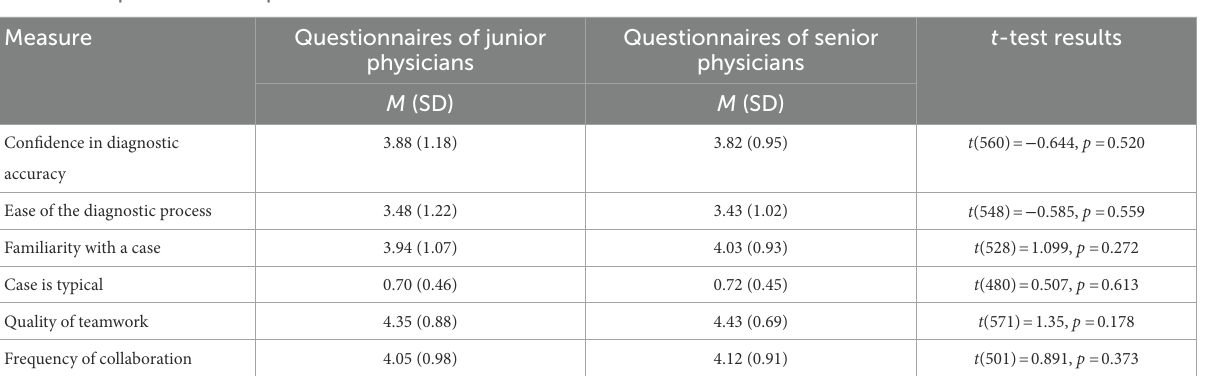
TABLE 3 Descriptive statistics of questionnaire